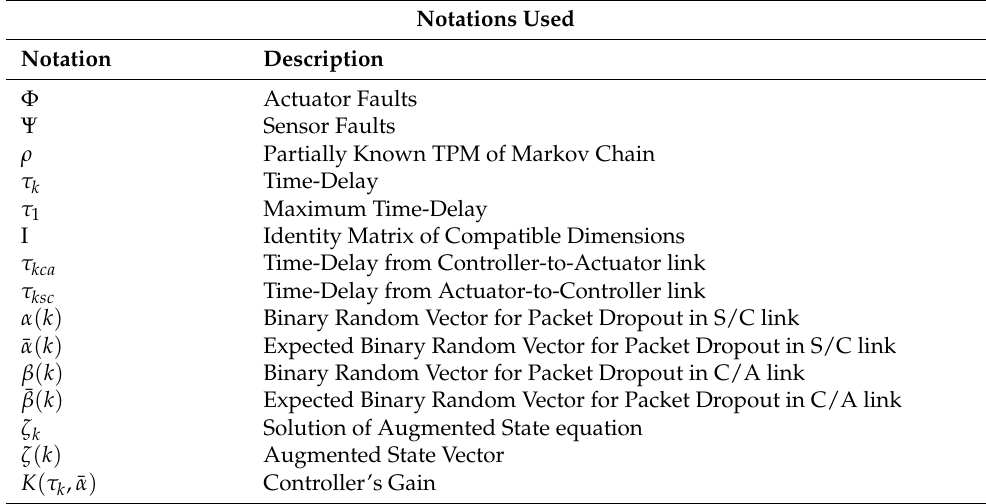
Table 1. Notation used throughout the